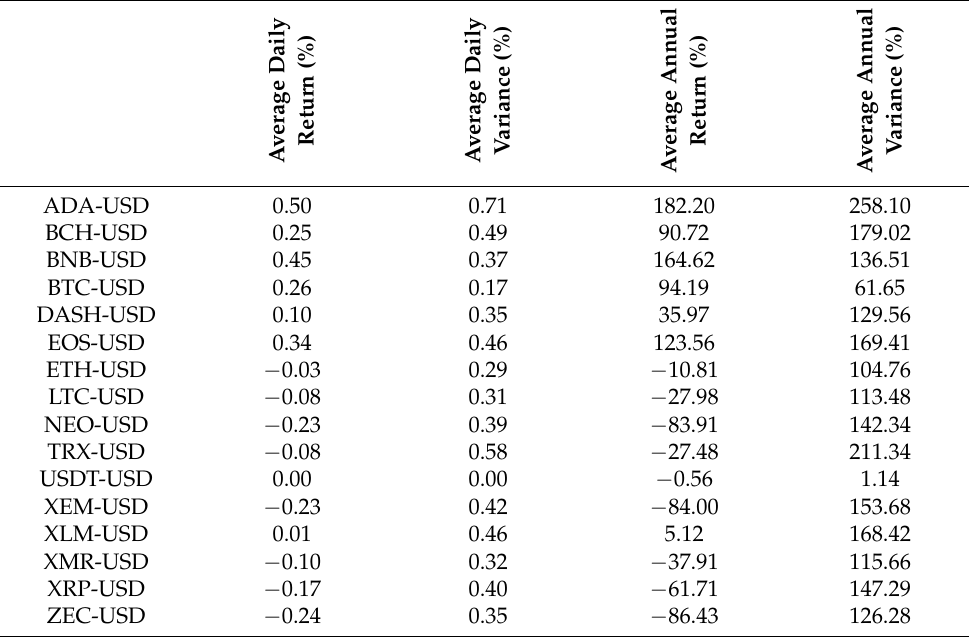
Table 3. Return and variance as component for portfolio